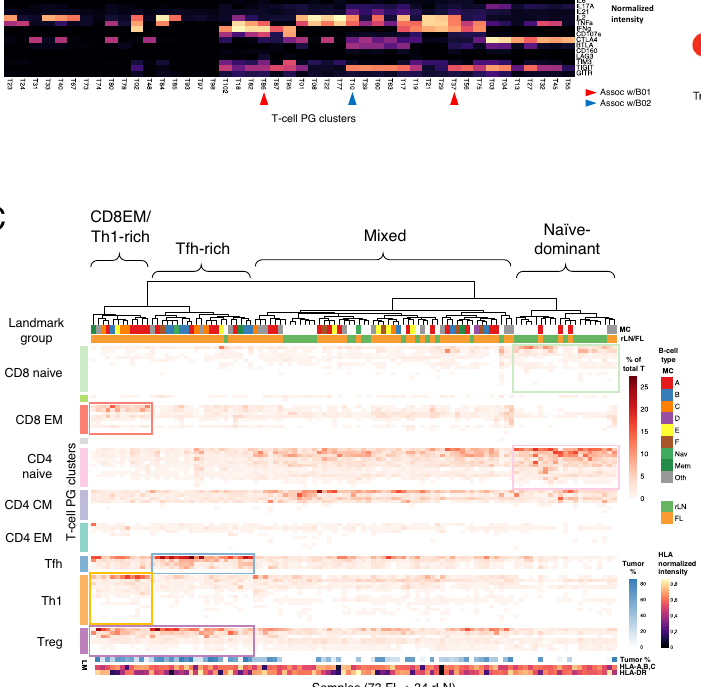
FLvs. rLN (FDR<0.05; 2-sidedSAM test). C Sample composition by T-cell clusters. Heatmap indicates cell abundances in each sample (each column adding up to 100%). PG clusters are arranged by landmark groups. Samples are hierarchically clustered into T-cell signature groups using Ward ’ s method on Jensen-Shannon divergence. Tumor cell % and HLA expression tracks refer to clonal B-cells within (73 FL and 34 rLN) and plotted the results in a force-directed map (Fig. 5A). Normal B-cells and various naïve and CM T-cell subsets